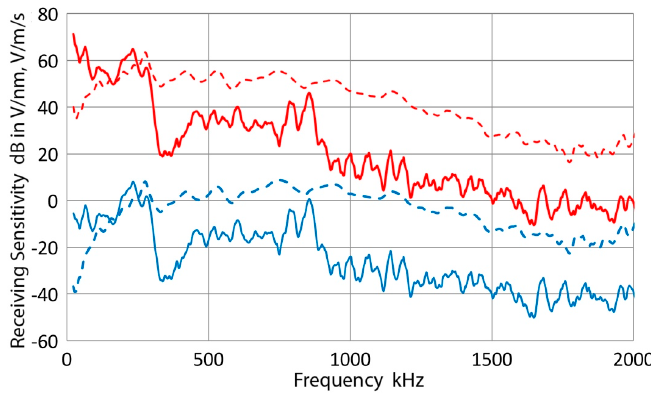
Figure 15. Receiving sensitivity of PAC WD (AC61). The displacement receiving sensitivities are shown in blue curves and velocity sensitivities are in red. Solid lines are for the bar-wave data, while dashed curves are for the sensitivities to normally incident waves.